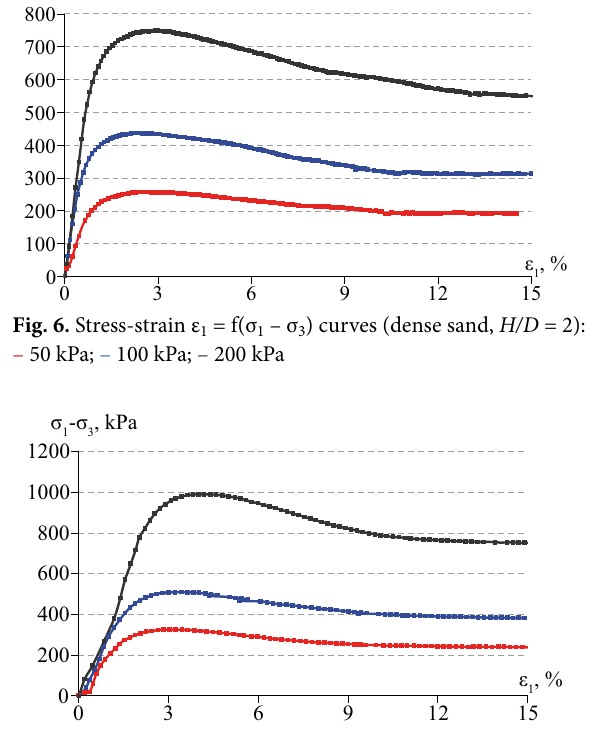
Fig. 7. Stress-strain ε 1 = ƒ(σ 1 – σ 3 ) curves (dense sand, H/D = 1): – 50 kPa; – 100 kPa; – 200 kPa